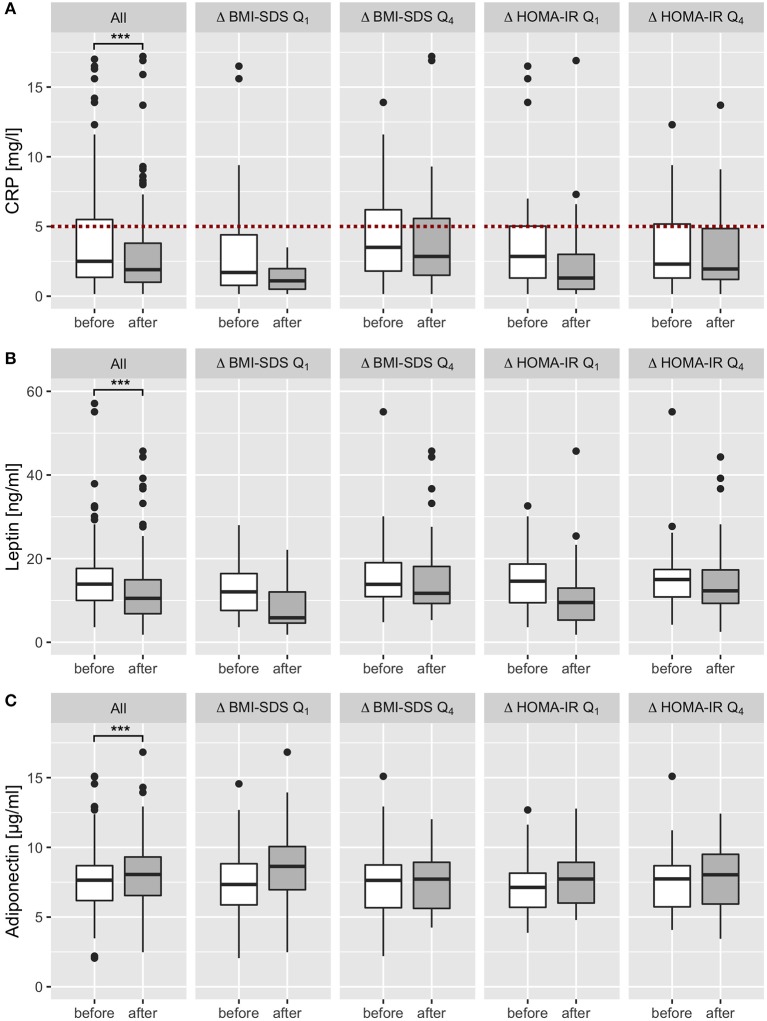
Effect of multidisciplinary intervention on biomarkers of metaflammation. After exclusion of all patients with acute infectious and chronic diseases, CRP, leptin and adiponectin levels were analyzed before (white) and after intervention (dark gray) and stratified by the effect on BMI SDS and HOMA IR (subgroup analysis of the first and last quartiles of Δ BMI SDS and Δ HOMA IR). CRP levels were widely within the reference range (<5 mg/l; red dotted line) and showed a significant decrease after intervention in all patients (A). Leptin levels decreased in all patients significantly; subset analysis showed a marked decrease in first quartiles (Q1) of BMI-SDS and HOMA-IR changes, and only a slight decrease in patients who showed no therapy success or aggravation (Q4) (B). Adiponectin levels increased in all patients significantly, subset analysis showed a marked increase in the first quartile (Q1) of BMI-SDS variation, a slight increase in the first quartile of HOMA-IR variation, and no change in the last quartile of BMI-SDS and HOMA-IR change (C). ***p < 0.001.